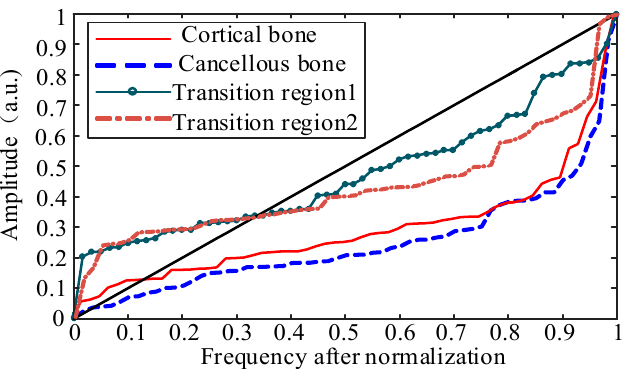
Figure 5. The relative distribution between amplitude and the frequency after normalization and sorting for the chosen frequency bands in different bone layers.